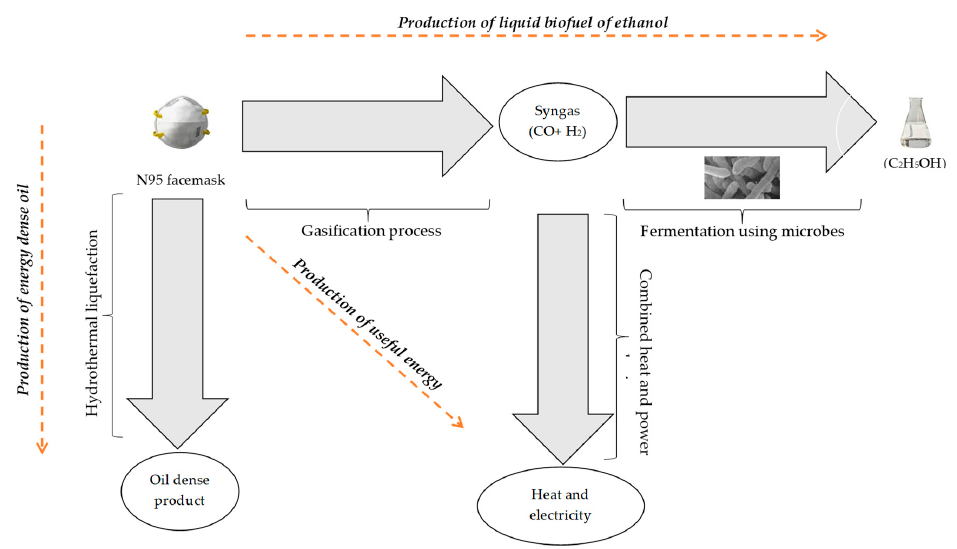
Figure 1. Pathways for value extraction from waste N95 facemask.